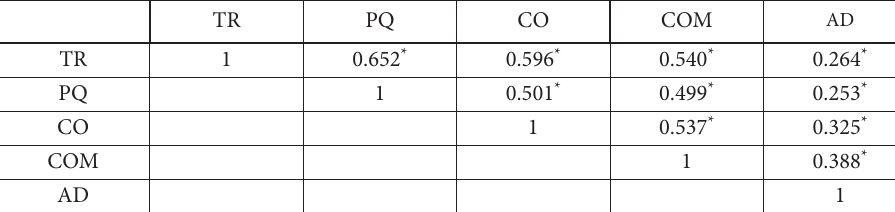
Table 3. Correlation between latent